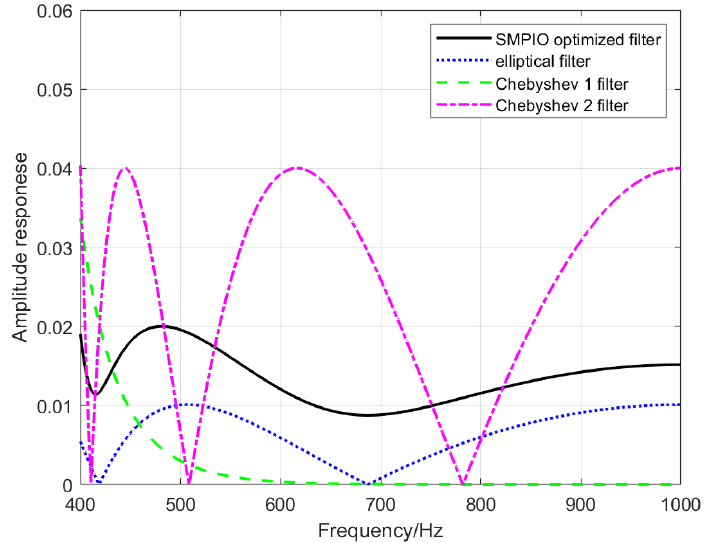
Figure 11. Amplitude response comparison of various types of filters (400 Hz~1000 Hz, m = 6, am- plitude and phase optimized).